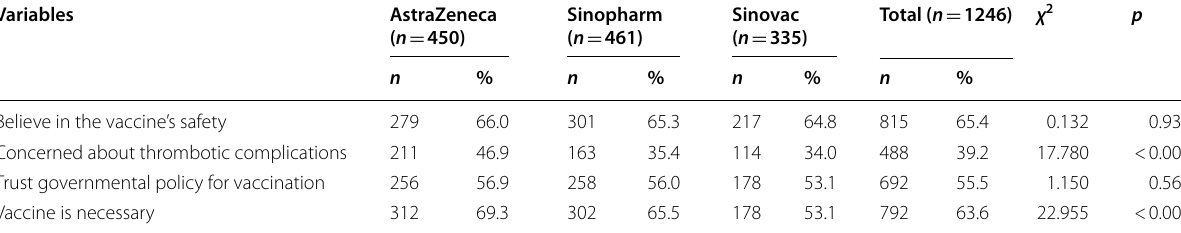
Table 2 Perceptions regarding the received vaccines among the participants Variables